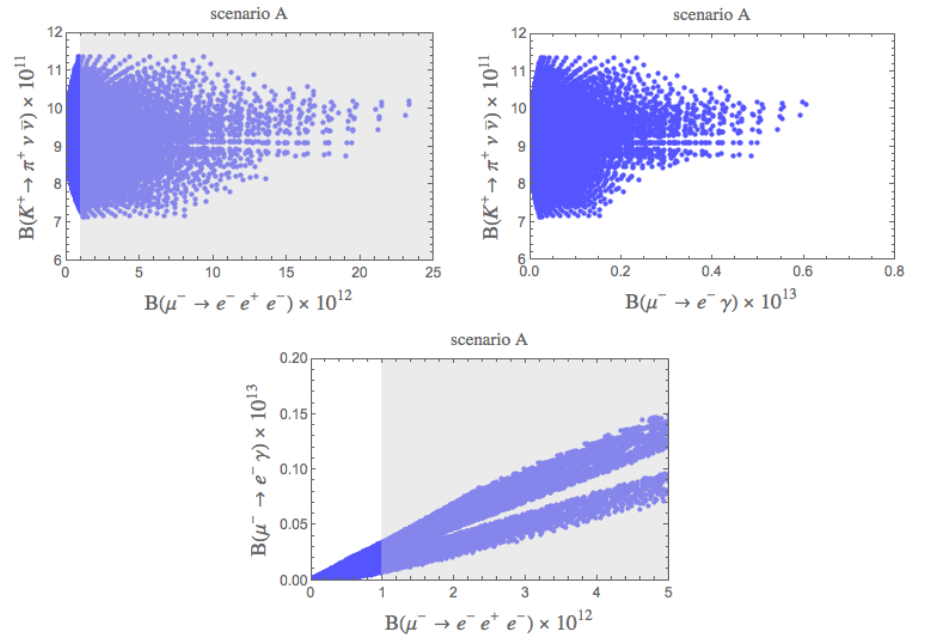
Figure 4 . Scenario A. Correlation between B ( K + ! (cid:25) + (cid:23) (cid:22) (cid:23) ) and B ( (cid:22) (cid:0) ! e (cid:0) e + e (cid:0) ) (upper left panel) and between B ( K + ! (cid:25) + (cid:23) (cid:22) (cid:23) ) and B ( (cid:22) (cid:0) ! e (cid:0) (cid:13) ) (upper right panel). Correlation between B ( (cid:22) (cid:0) ! e (cid:0) (cid:13) ) and B ( (cid:22) (cid:0) ! e (cid:0) e + e (cid:0) ) (lower panel). The gray shaded regions are excluded by the experimental bound B ( (cid:22) (cid:0) ! e (cid:0) e + e (cid:0) ) < 1 (cid:1) 10 (cid:0) 12 . Figure 5 . Scenario A. Correlation between B ( (cid:22) (cid:0) ! e (cid:0) ) and B ( (cid:22) (cid:0) ! e (cid:0) e + e (cid:0) ) (left panel). The gray shaded region is excluded by the experimental bound B ( (cid:22) (cid:0) ! e (cid:0) e + e (cid:0) ) < 1 (cid:1) 10 (cid:0) 12 . Correlation between B ( (cid:22) (cid:0) ! e (cid:0) ) and B ( K + ! (cid:25) + (cid:23) (cid:22) (cid:23) ) (right